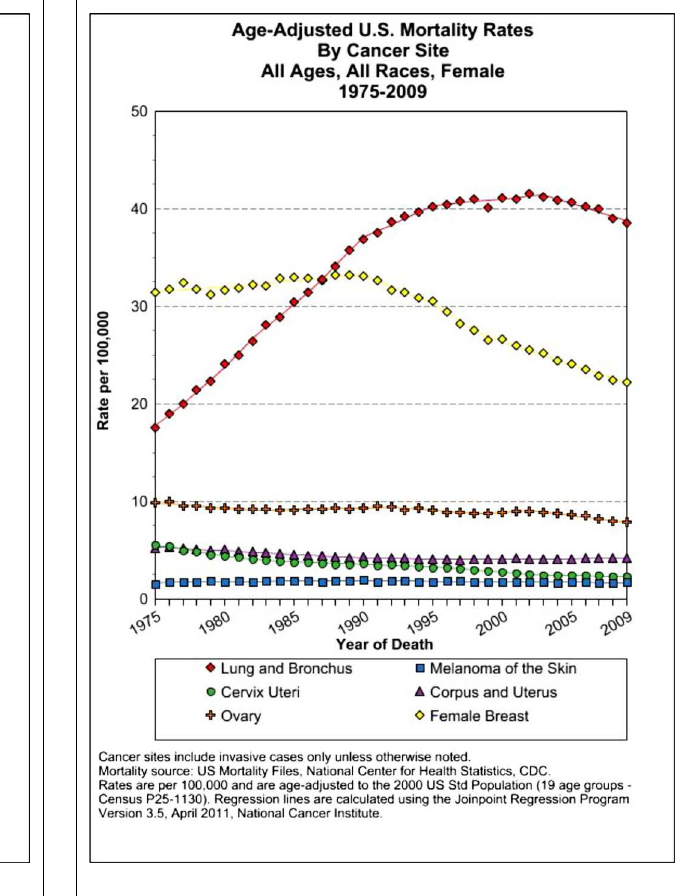
FIGURE 3 |Age-adjusted mortality rates for specific cancer types in females, all races combined, US SEER data (Howlader etal.,